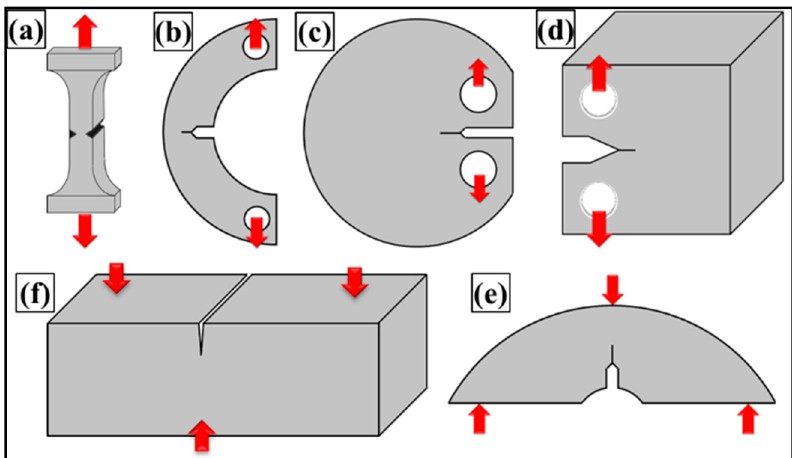
Figure 1. Various fracture toughness test specimen geometries: ( a ) notched tensile; ( b – d ) compact tension; ( e ) compact bend; and ( f ) single-edge notched three-point bend specimens. The arrows indicate the axis of loading.